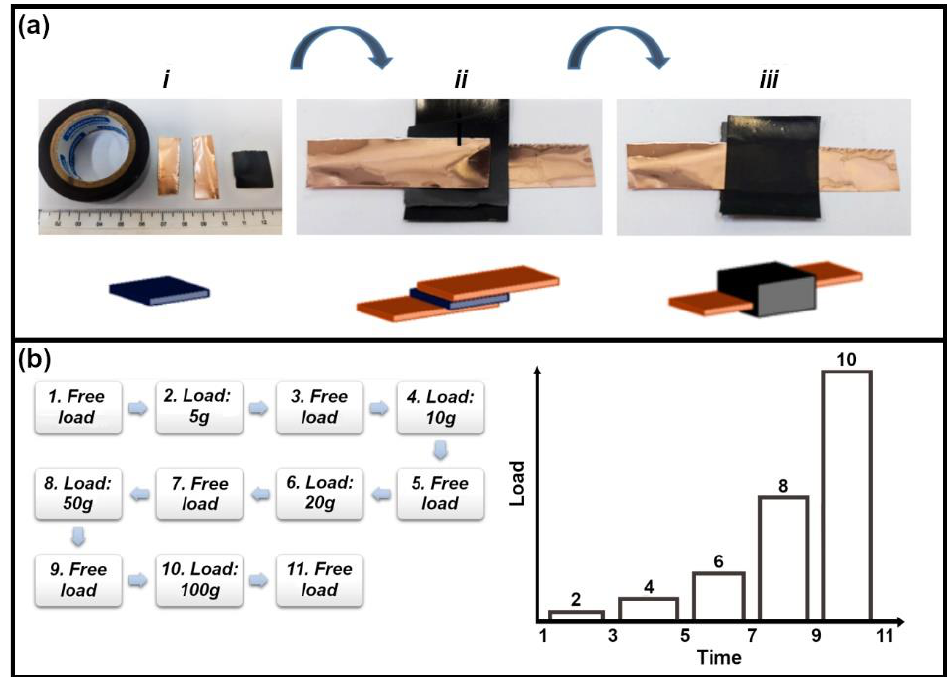
Figure 1. Preparation of the sensor prototype where: ( a ) membrane cut (i); copper foil assembly (ii) and insulator assembly (iii); ( b ) scheme illustrating loading and unloading cycles with the values of the applied weights and illustration of computed data, load x time.